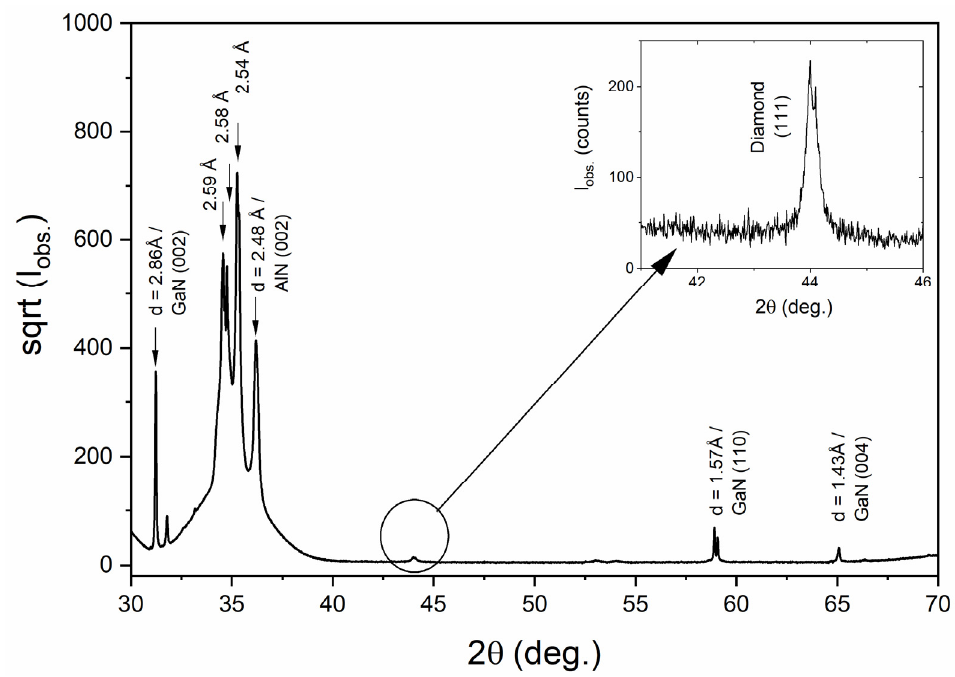
Figure 5. X-ray diffraction pattern for BBD-7k@GaN. The intensity is on square root scale. The inset shows a small (111) reflection of a diamond